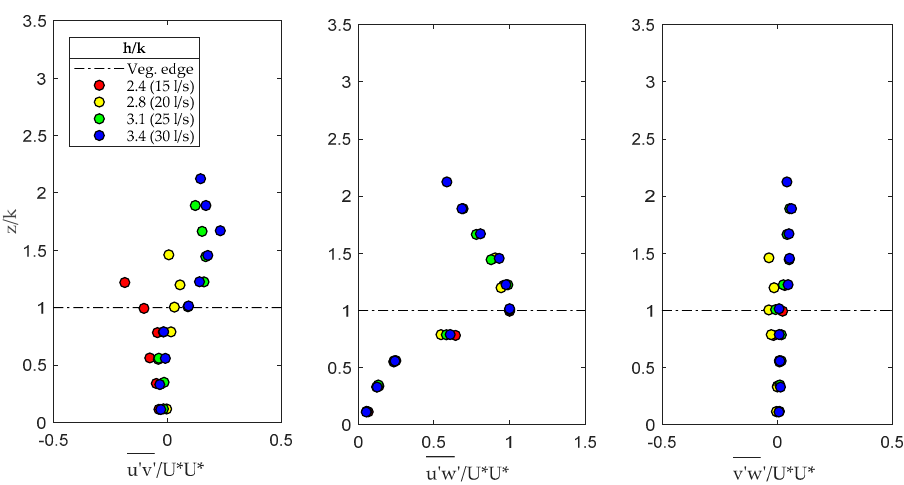
Figure 7. Reynolds stress profiles. The quantities are normalized with square of the friction velocity at the canopy top U ∗ .